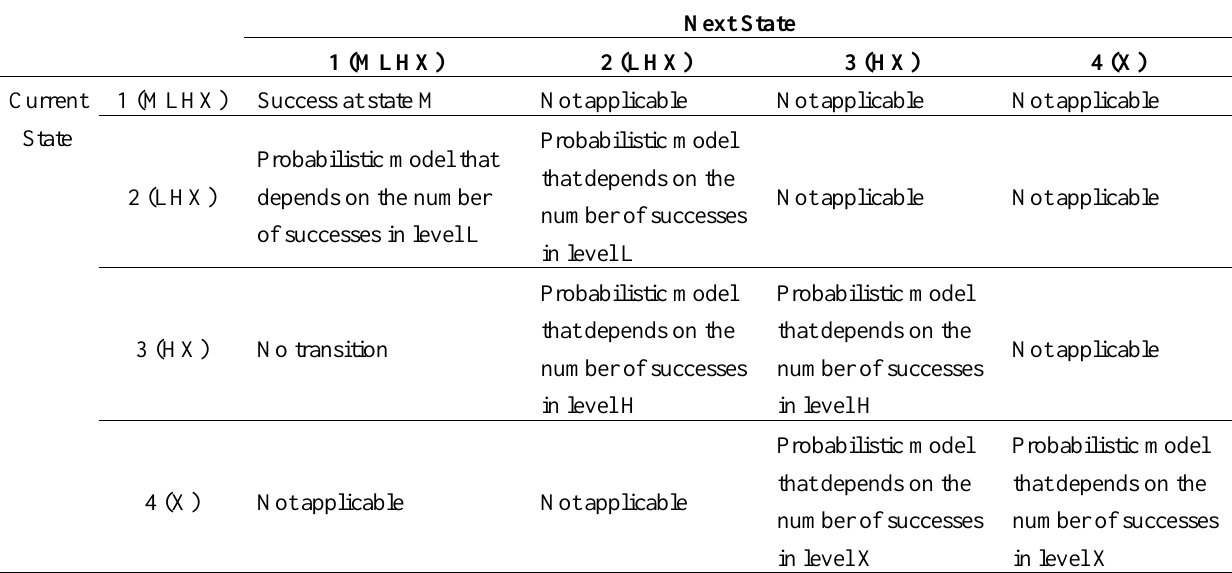
Table 4. State transition matrix when state levels go